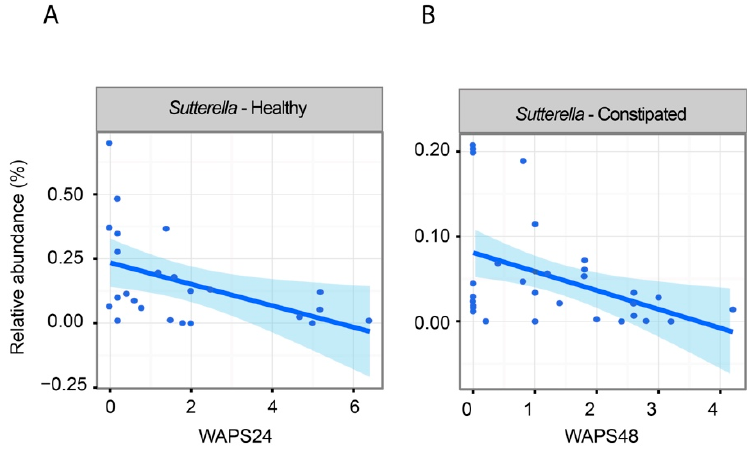
Figure 3. Associations between whole gut transit time and bacterial abundance measured from all available data points: ( A ) relative abundance of genus Sutterella and transit time measure (weighted average position score, Weighted Average Position Score (WAPS) measure 24 h after ingestion of transit markers, smaller number indicates longer transit) in healthy subjects; ( B ) relative abundance of genus Sutterella and transit (WAPS) measured 48 h after ingestion of transit markers in constipated subjects.